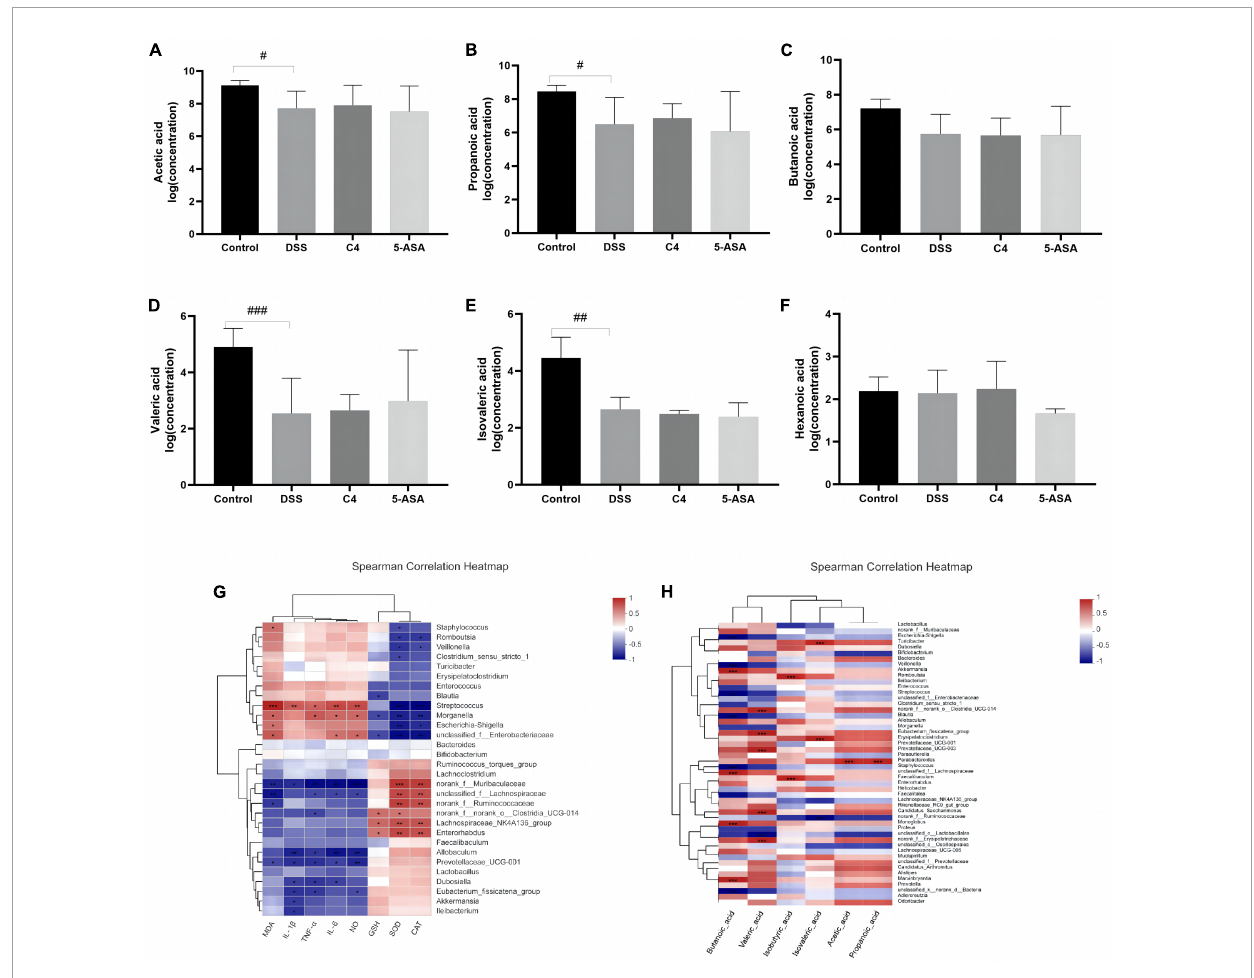
FIGURE4 Effect of The L. acidophilus C4 on the production of SCFAs. Data are subjected to one-way ANOVA statistics and presented as mean ± standard deviation ( n = 4). Three replicates were set for each group. (A–F) Changes in SCFAs levels in rat feces. (G) Heatmap of the correlation between inflammatory cytokines and oxidative stress on gut microbiota at gene level. (H) Heat map of the correlation between SCFAs and intestinal microbiota at gene level. # P < 0.05, ## P < 0.01 and ### P < 0.01 vs. Normal